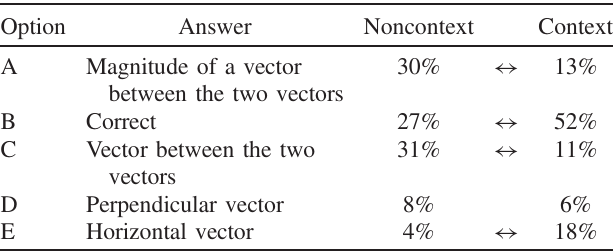
TABLE IV. Results of item 2: Students have to interpret the dot product of two vectors or work defined as a dot product as a projection. The arrows indicate which options have significantly different distributions determined by p < . 01 on chi-square